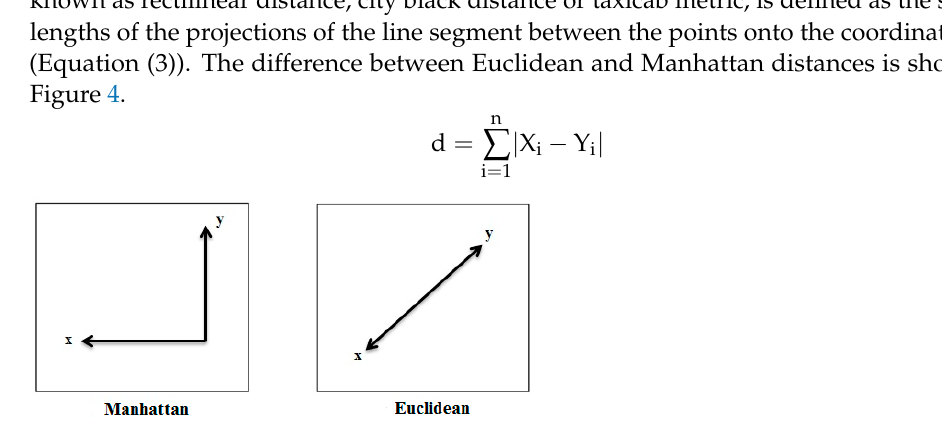
Figure 3. Euclidean distance between points p and q .